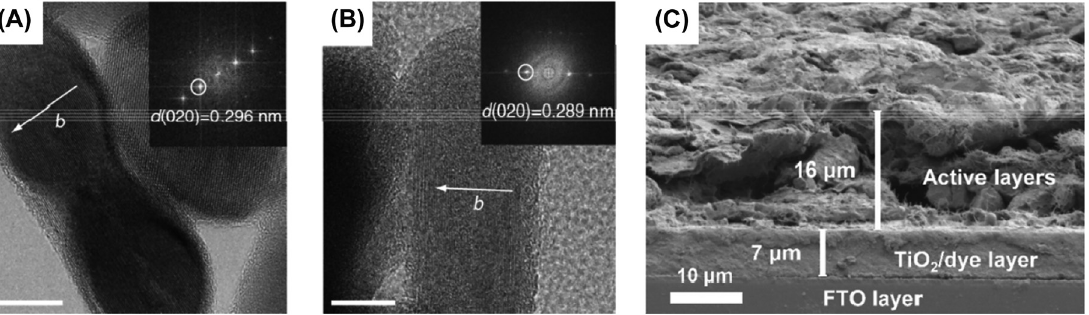
Figure 3: Structure and morphology of dye-sensitized photoelectrodes. (A)HRTEMofpristineLFP(scalebars,10nm)and(B)HRTEMofLFPafterlightexposure(scalebars,10nm)[60]Copyright2017,SpringerNature. (C) High magni fi cation cross-sectional view SEM images of the hybrid N719/S cathode [113] Copyright 2022,